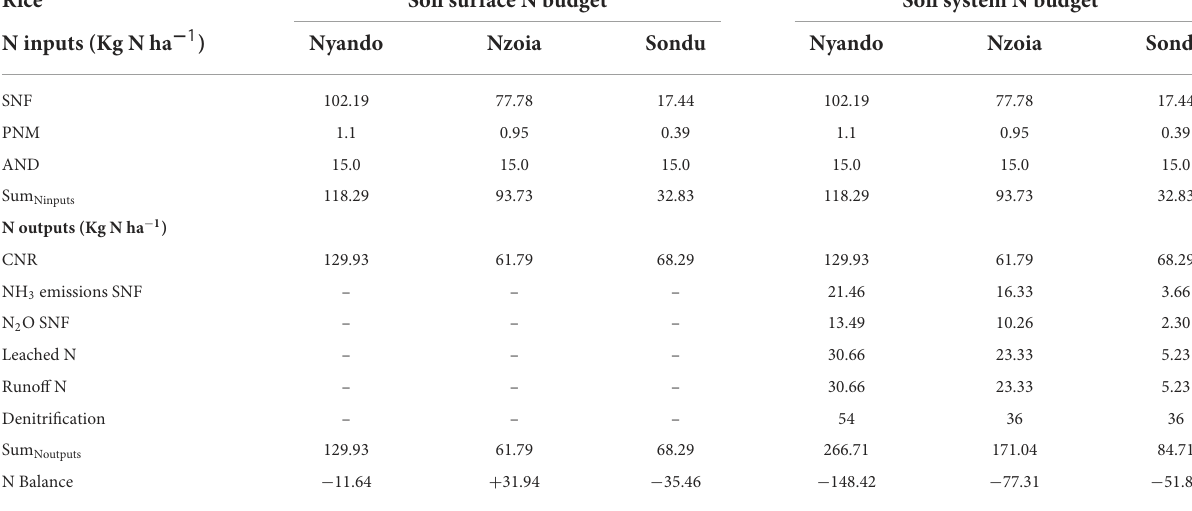
TABLE 2 Rice soil surface and soil system N budget in main rice-growing catchments in Lake Victoria basin. Rice